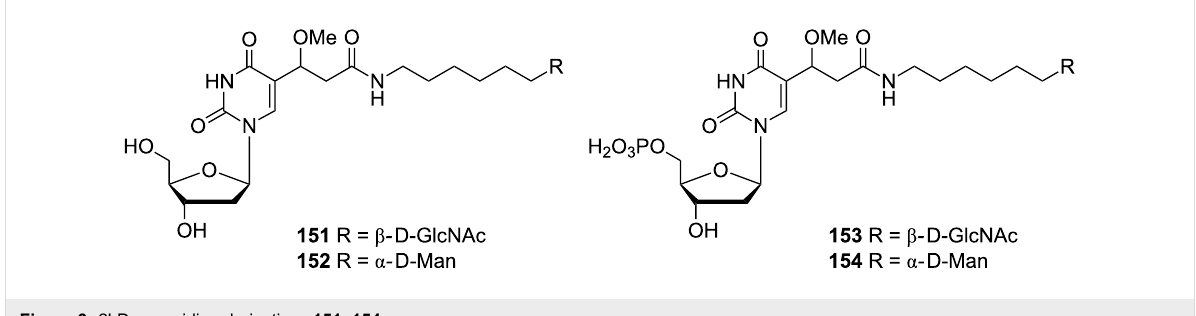
Figure 9: 2'-Deoxyuridine derivatives 151 – 154 .